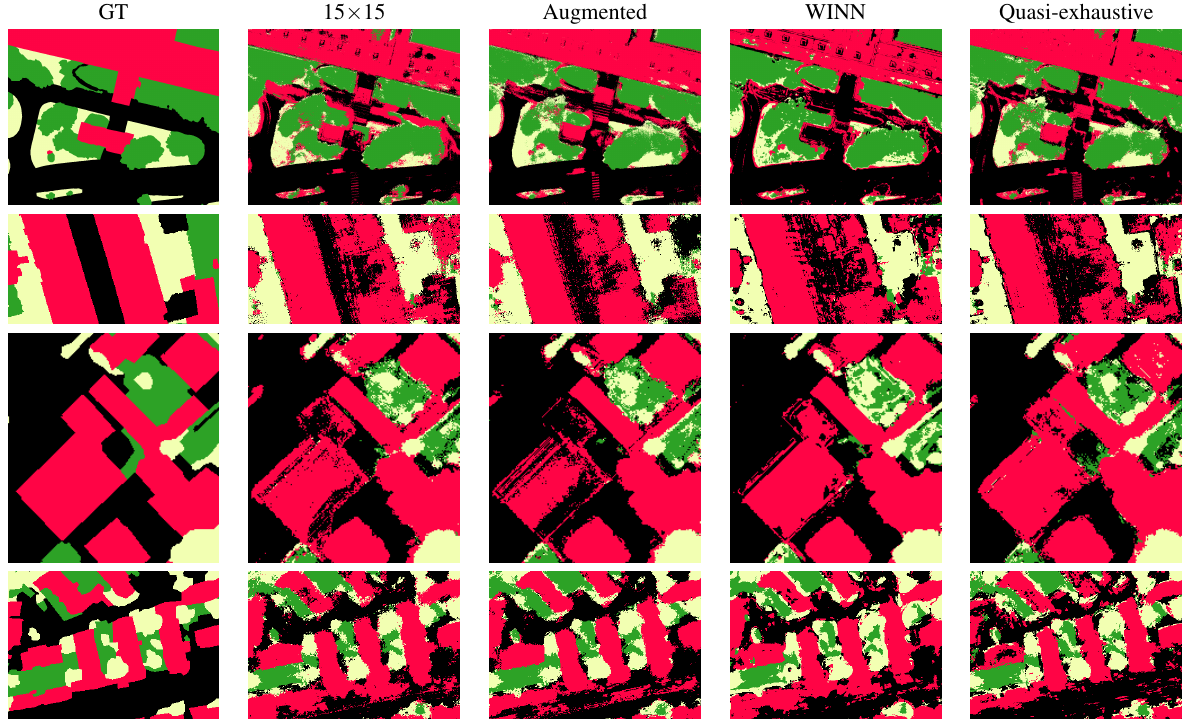
Figure 4: Ground truth (GT) and classification results of four different scenes using boosting (row-wise top to bottom: K LOTEN , G RAZ , V AIHINGEN , W ORLD V IEW -2). Streets are displayed black, buildings red, high vegetation green, and low vegetation yellow. K LOTEN and G RAZ show results of the entire test area without the nDSM channel, V AIHINGEN and W ORLD V IEW -2 show zoomed details of the results using the nDSM